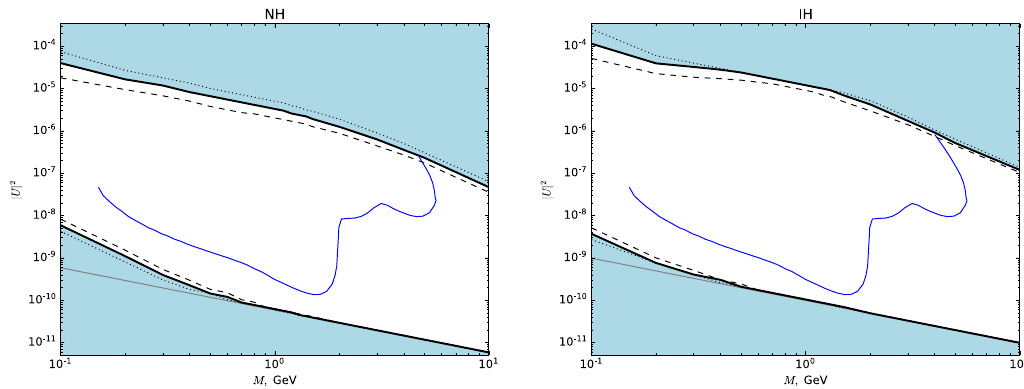
Figure 1 . Within the white regions it is possible to reproduced the observed value of the BAU (black solid curves). The dashed and dotted curves demonstrate how large the possible theoretical uncertainties could be. Namely, the dashed curves correspond to the condition Y whereas the dotted lines correspond to Y the computation of the BAU. The thin grey lines show the see-saw limit, i.e. it is impossible to obtain the correct masses of active neutrinos below these lines. The blue line shows the projected sensitivity of the SHiP experiment ref. [65] as presented in ref. [66]. Left panel : normal hierarchy, right panel : inverted